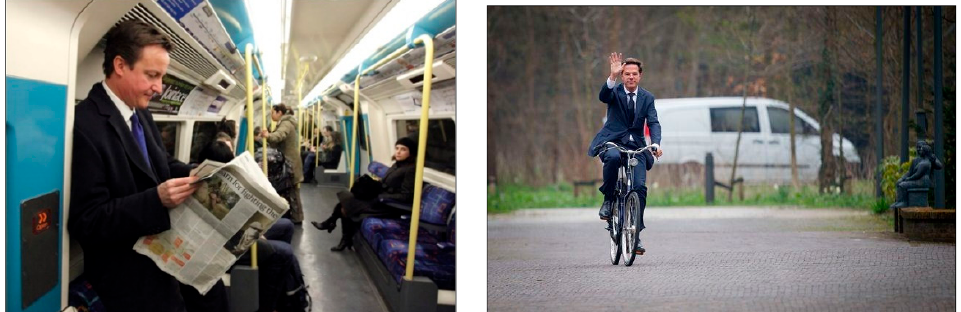
Figure 31. ( left ) David Cameron, former Prime Minister of the UK, using the London metro (Sources: The Friday Times. Adapted from [43]); ( right ) Mark Rutte, Prime Minister of the Netherlands, traveling by bike (Sources: Invest in Holland Network. Adapted from